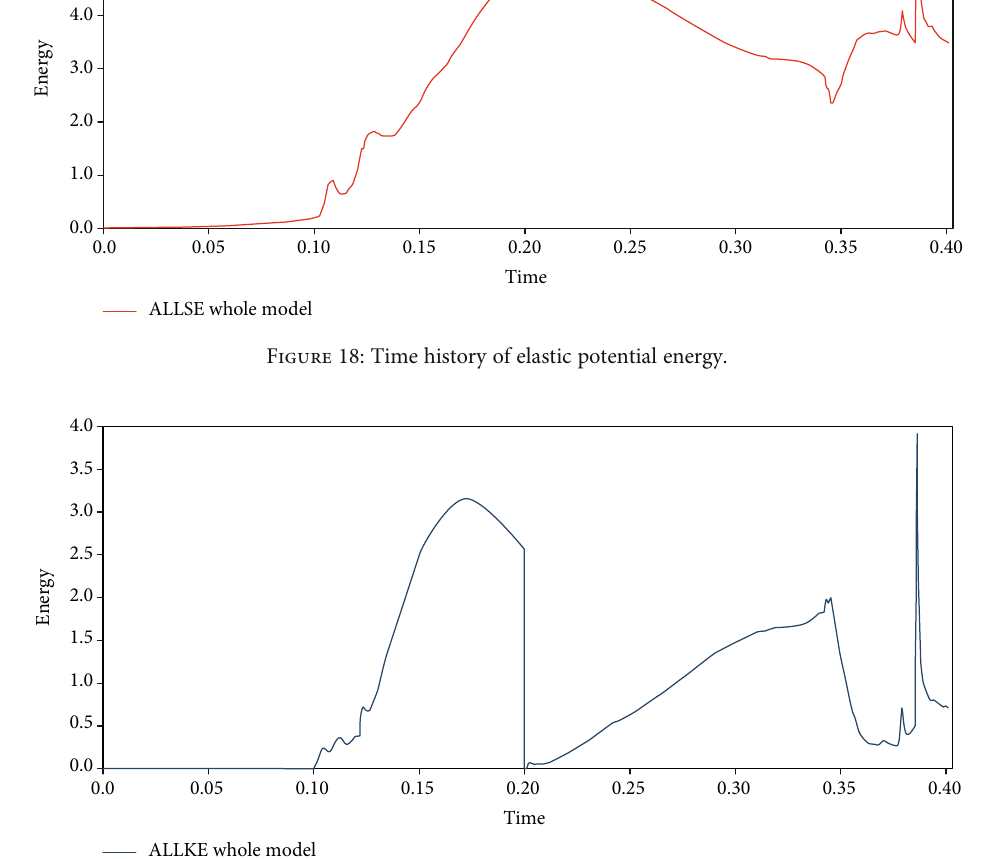
Figure 19: Time history of kinetic energy.